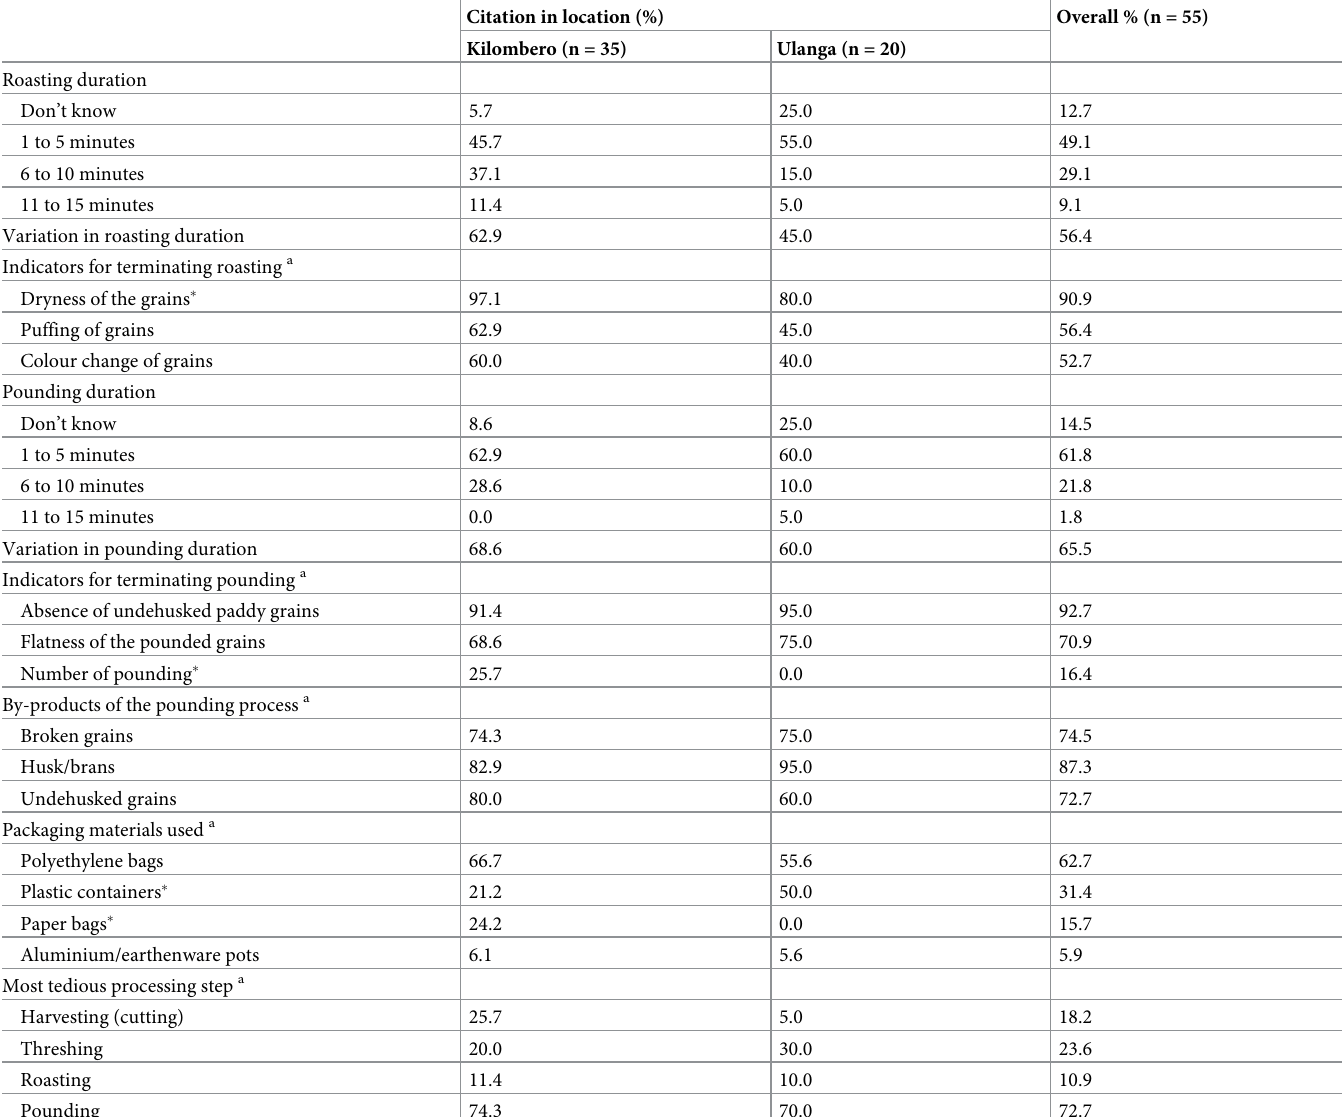
Table 8. Overview of main pepeta processing steps in the study